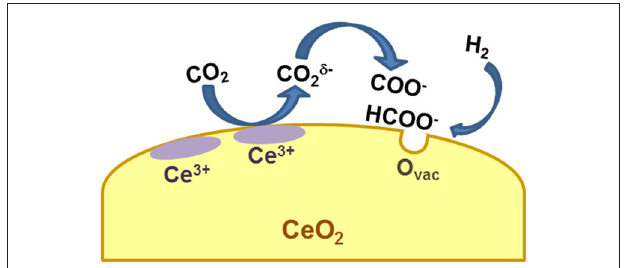
FIGURE 1 | Proposed mechanism for CO 2 activation on ceria